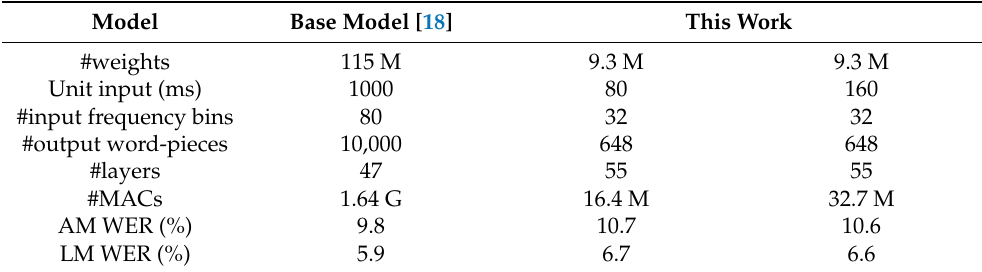
Table 4. Comparison with the base model [18] in software (32-bit floating-point, 960 h LibriSpeech for training, LibriSpeech test-clean for